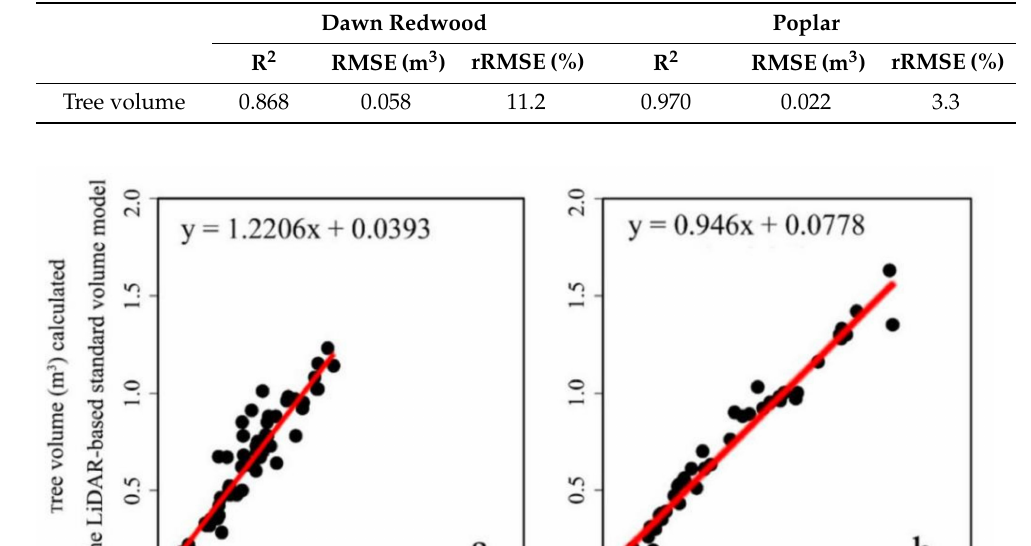
Table 8. Analysis of the accuracy of the standard volume equations of dawn redwood and poplar.